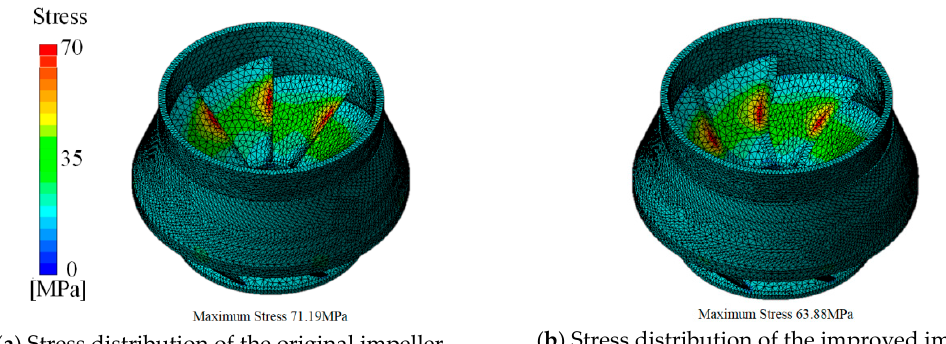
Figure 7. Comparison of stress distribution before and after impeller improvement.